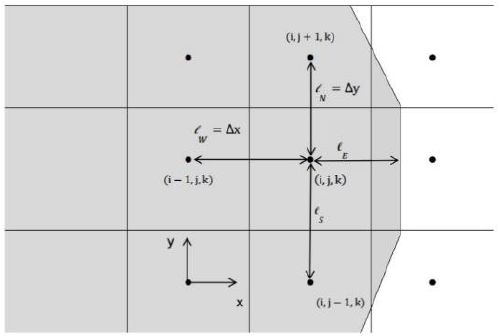
Figure 1. Points used for computing the pressure variables.